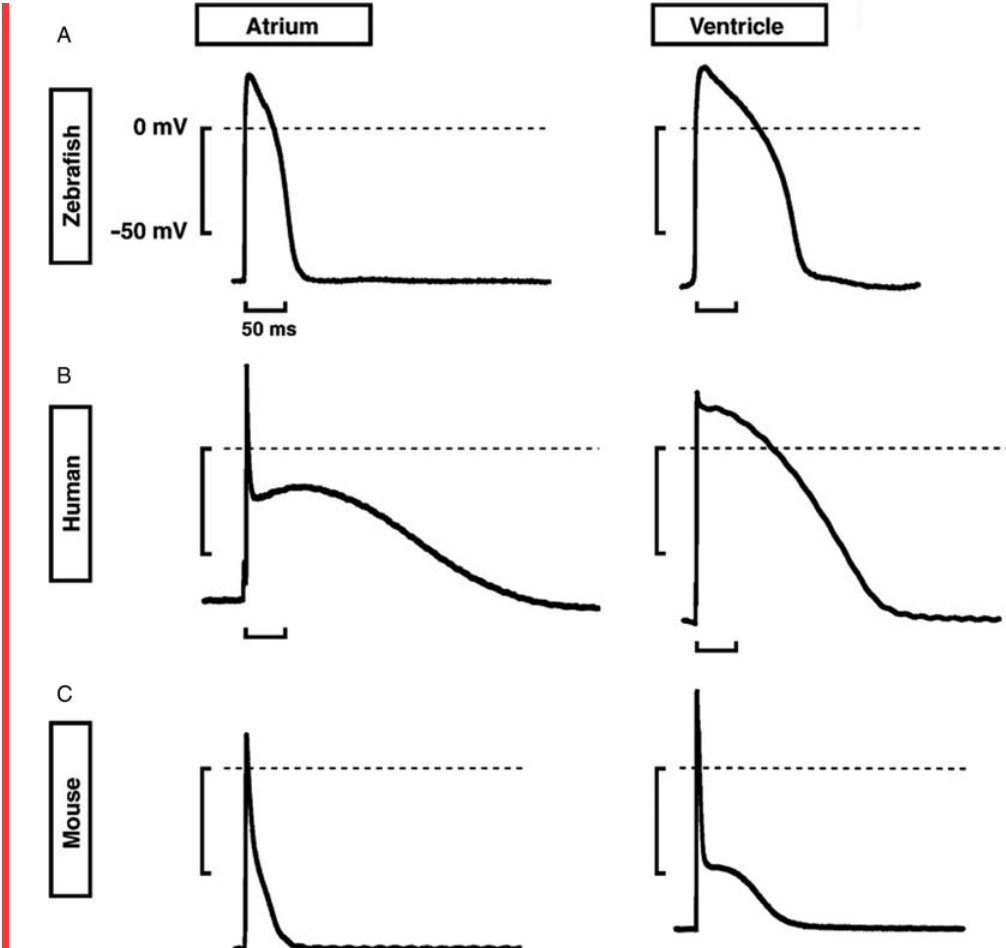
Figure 4. Atrial and ventricular action potentials in the zebrafish, human and mouse. Representative shapes of action potentials in (A) zebrafish, (B) human, and (C) mouse. Note the similarity between the ventricular action potentials in humans and zebrafish. From 119 with